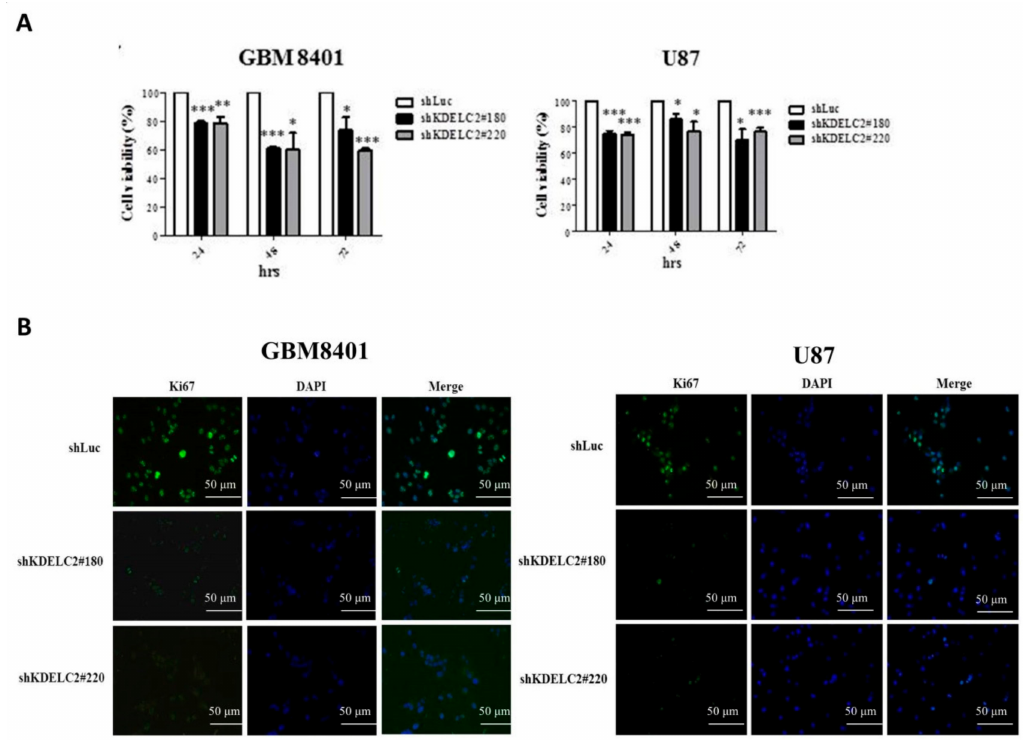
Figure 3. KDELC2 knockdown impacted GBM proliferation. ( A ) GBM with shKDELC2 transfection inhibited tumor viability. Bars, means ± SEM. * p < 0.05; ** p < 0.01; *** p < 0.0001. ( B ) Immunofluorescence assay confirmed that knockdown of KDELC2 decreased the proliferative